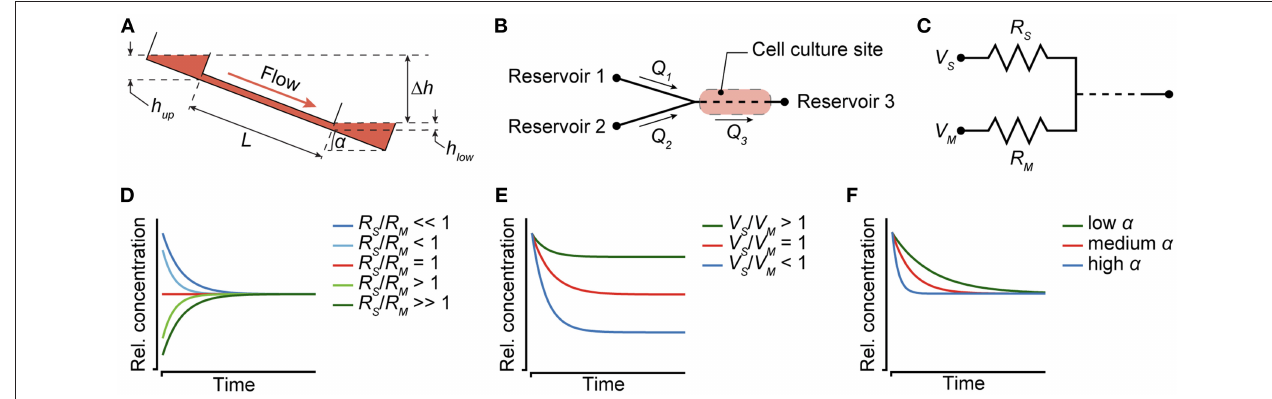
FIGURE 3 | Modulation of concentration profiles. (A) Flow in the chip is dependent on the tilting angle α and the resulting height difference ∆ h between the liquid levels in the reservoirs at the left and right side. (B) Two reservoirs that are connected to channels with unequal flow rates Q 1 and Q 2 feed into a Y-junction. The flow-rate difference can be generated by different channel widths or dimensions. A cell culture site is located between the Y-junction and a third reservoir, and can be subjected to dynamic substance concentration profiles. (C) The channel resistances R S and R M , the initially applied liquid volumes V S and V M , and the tilting angle α can be used to modulate the concentration profiles. (D) The ratio of resistances can be used to define the time, after which an equilibrium is reached (for constant V and α ). (E) The ratio of input volumes in reservoirs 1 and 2 defines the concentration, at which an equilibrium is reached (for constant R and α ). (F) The tilting angle α modulates the slope of the concentration profile (for constant R and V